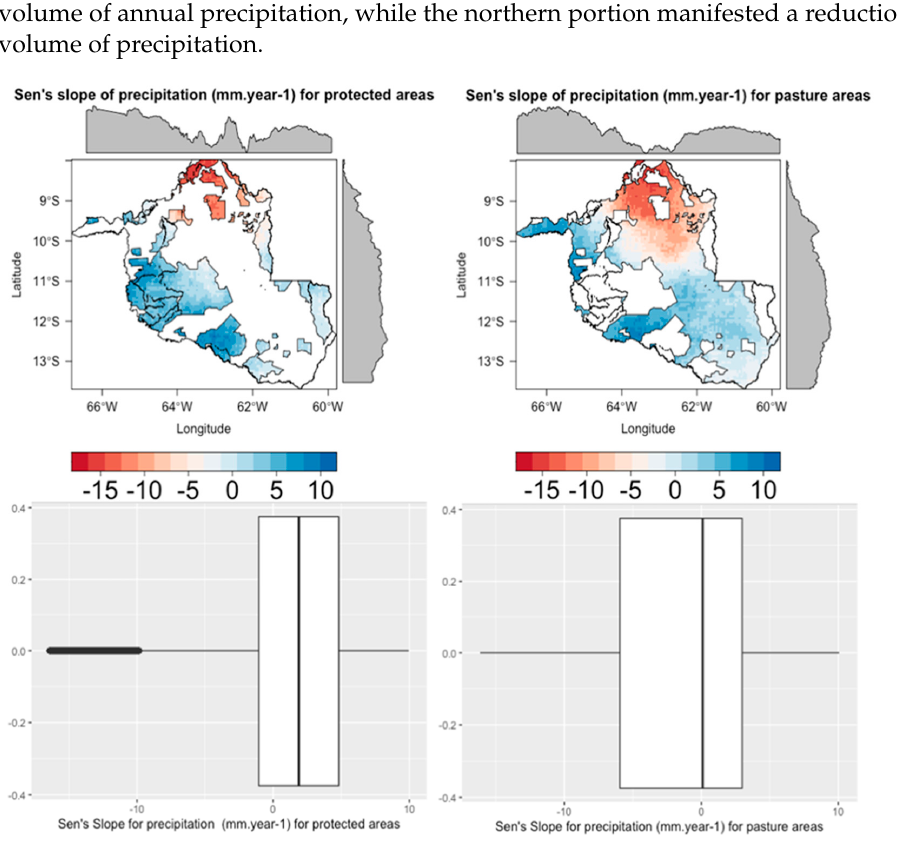
Figure 6. Spatialization of the Sen’s Slope of magnitude of change in the yearly behavior of precipitation in the state of Rondônia, in which the polygons represent protected areas. 3.4. Spatial Analysis of Precipitation Trends in the State of Rondônia Separated per Dry and Rainy Season for Anthropized and Primary Forest Areas Regarding the twelve months of the year, those with the highest accumulated rainfall were January, February, March and December. The average values for these months were above 200 mm and, therefore, reaffirming that the trimester (January, February, March) is the wettest of the year in the Tropical rainforest climate. Figure 7 registers the Box-Plot of monthly rainfall and seasonal variability with rainfall data from the rain gauge and CHIRPS.